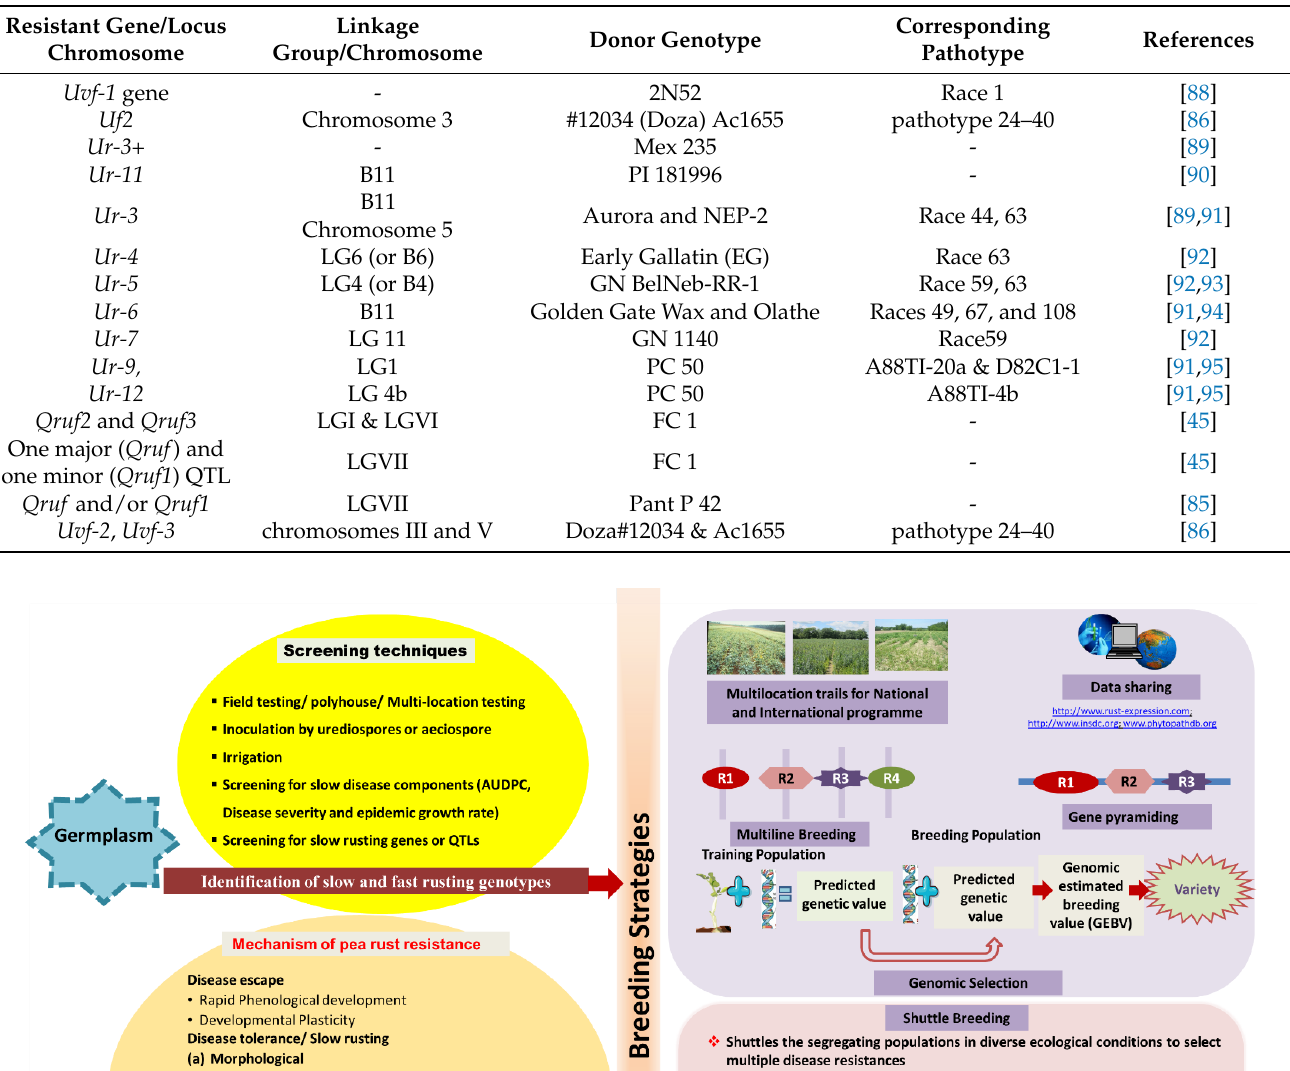
Table 3. List of resistant genes/QTLs against Uromyces viciae-fabae Pers. de-Bary.